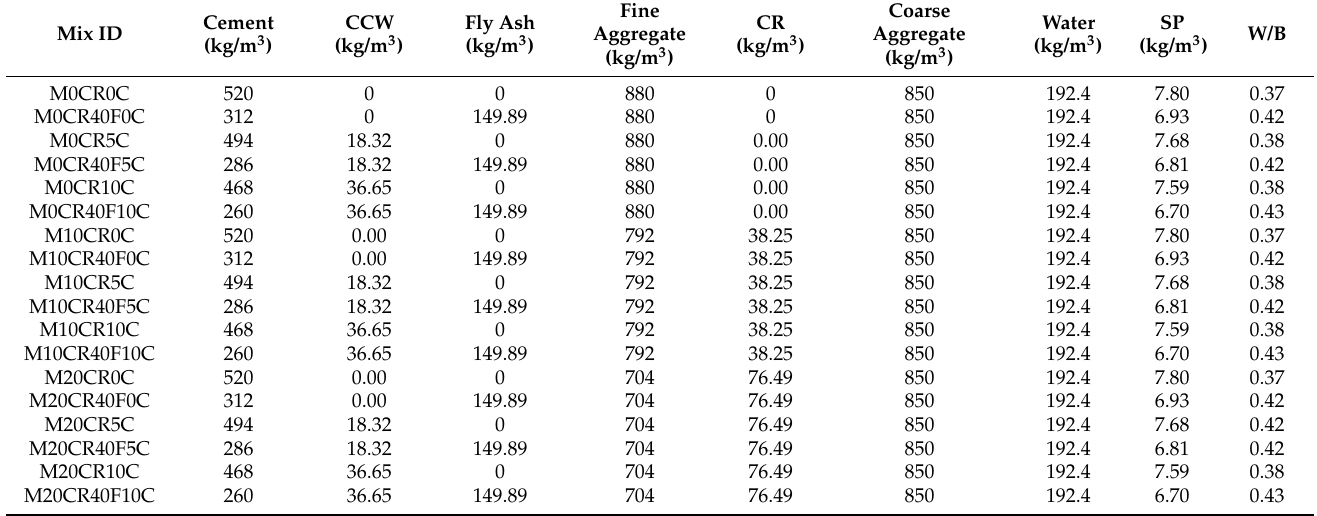
Table 2. Mix Table 2. Mix Proportioning.